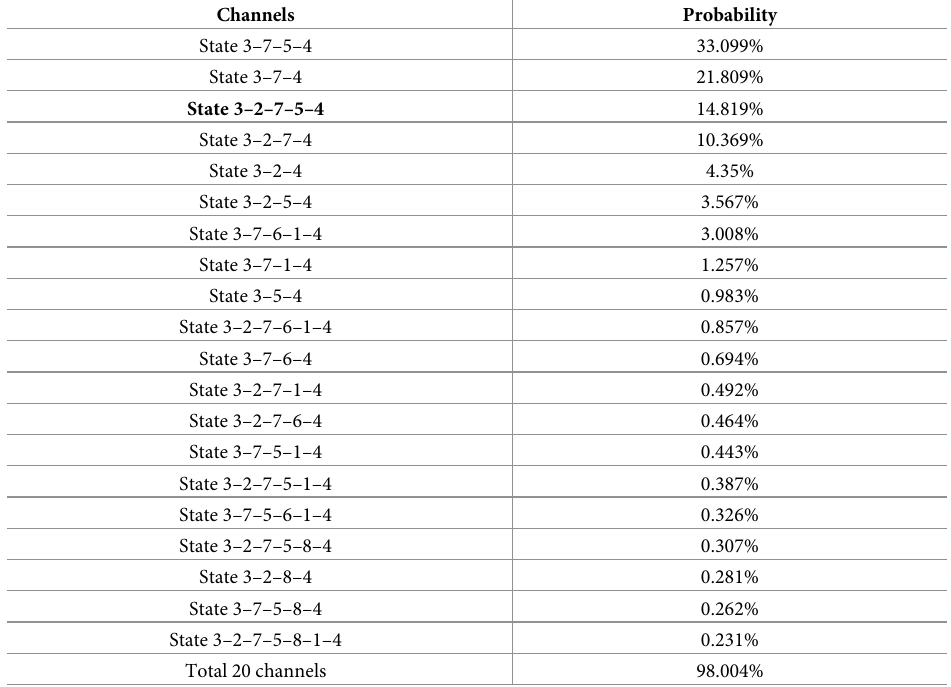
Table 4. The probability of top 20